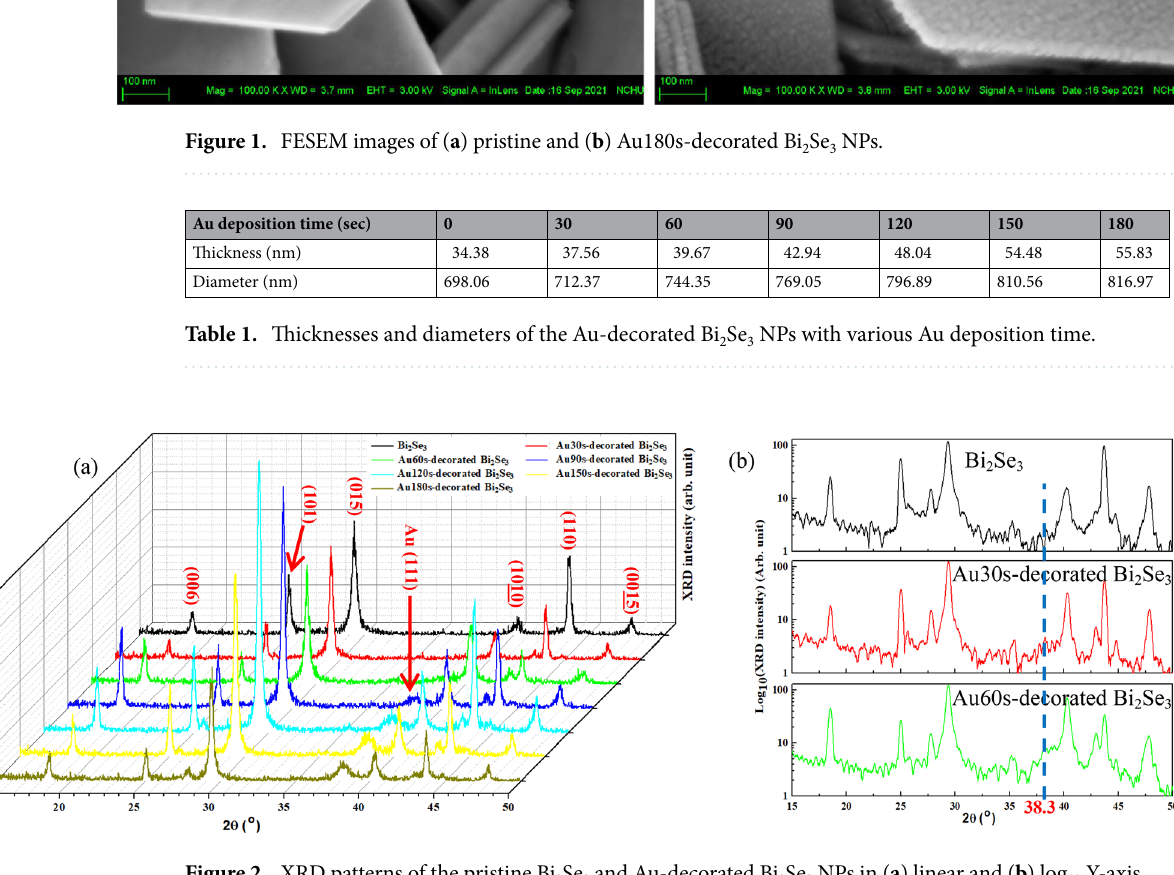
Figure 2. XRD patterns of the pristine Bi 2 Se 3 and Au-decorated Bi 2 Se 3 NPs in ( a ) linear and ( b ) log 10